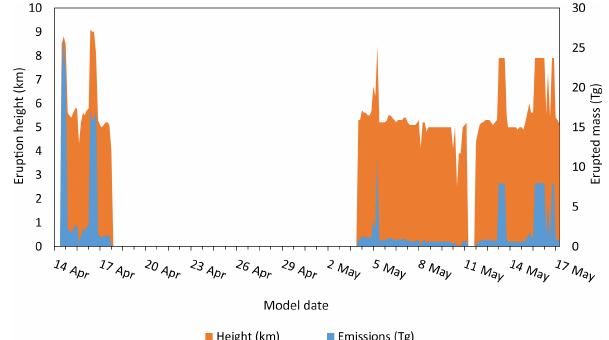
Figure 2. Three hourly plume heights (KM) above sea level (or- ange, km) and emitted mass (blue, Tg) used in the WRF-Chem mod- eling simulations (volc_d01.asc name list) for the eruption period 12 April until 18 May 2010. Values adapted from Hirtl et al. (2019) with dates as